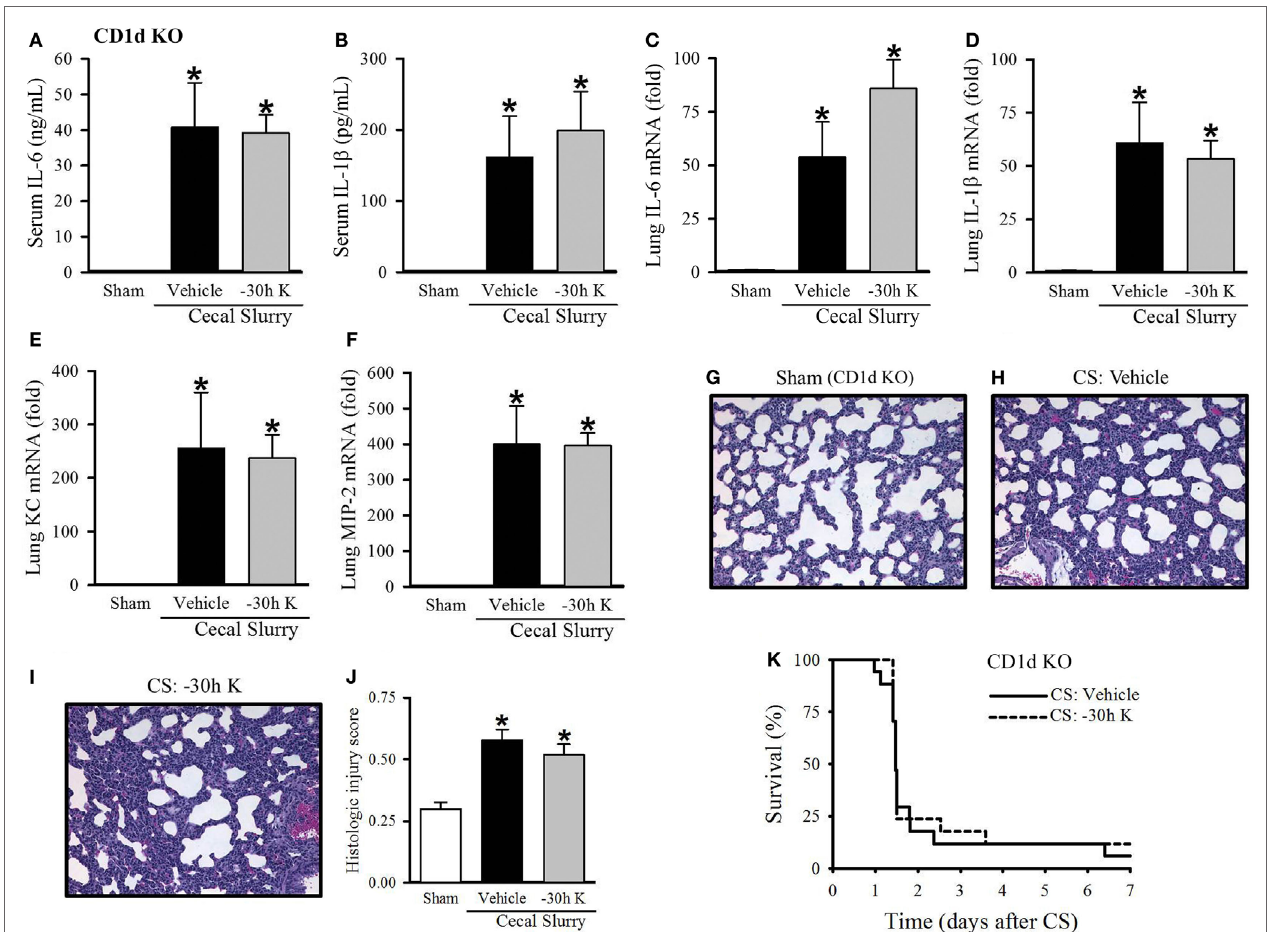
FigUre 5 | Effect of − 30 h KRN treatment on inflammation, pulmonary injury, and survival in septic CD1d knockout (KO) neonatal mice. Neonatal CD1d KO pups received KRN (0.2 µg/g BW) or vehicle (2.5% dimethyl sulfoxide in PBS) intraperitoneal (i.p.) 30 h prior to sepsis induction. Sepsis was induced by i.p. injection of cecal slurry (CS) (0.9 mg/g BW); serum and lungs were harvested 10 h later. Serum levels of (a) IL-6 and (B) IL-1 β were measured by enzyme-linked immunosorbent assay. The mRNA levels of (c) IL-6, (D) IL-1 β , (e) keratinocyte chemoattractant, and (F) macrophage inflammatory protein-2 in the lungs were determined by qPCR. (g–i) Shown are representative hematoxylin and eosin-stained sections of the lung from (g) sham, (h) vehicle-, and (i) − 30 h KRN-treated mice at 200 × magnification. (J) Histologic lung injury score was calculated for each group with a maximum possible score of 1. Data expressed as mean ± SEM ( n = 6–8 per group) and compared by one-way analysis of variance (* p < 0.05 vs. Sham). (K) Another set of pups received the same dose of KRN or vehicle 30 h prior to sepsis induction by CS (0.175 mg/g) and survival was monitored for 7 days ( n = 17 per group, p = 0.667, log-rank